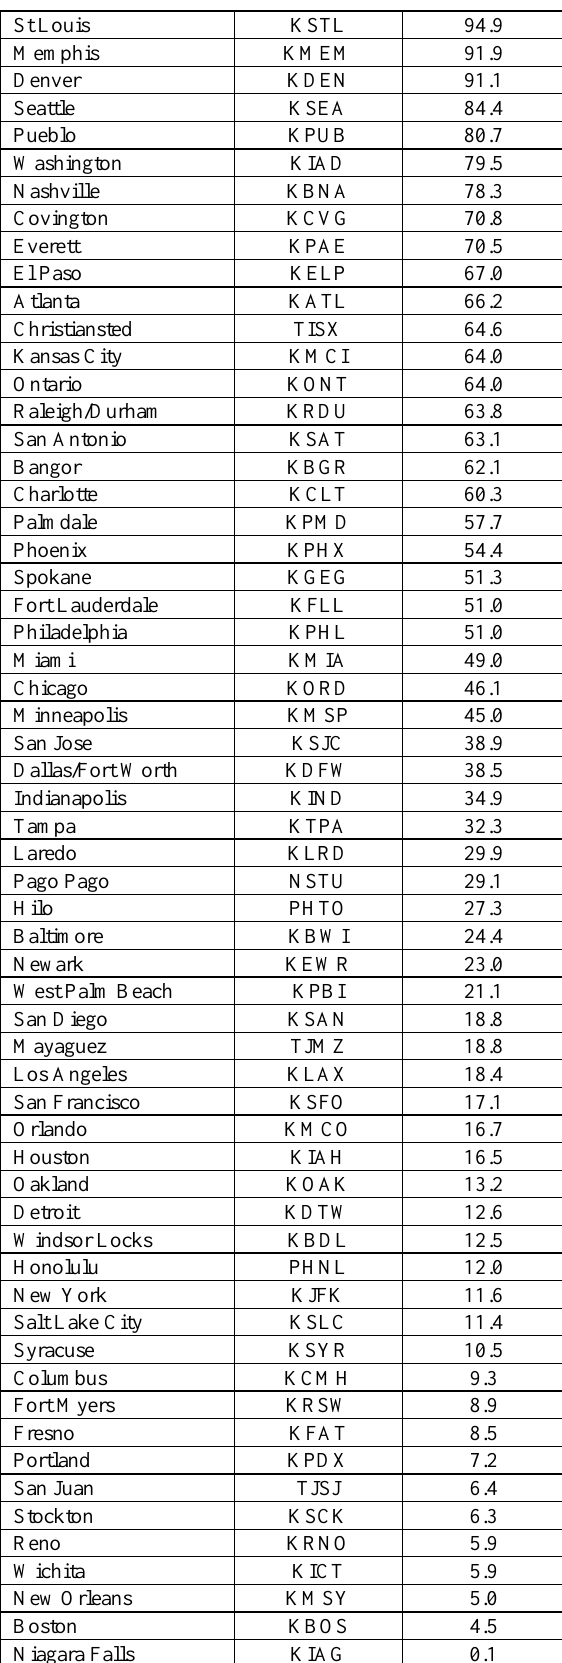
Figure 3. Histogram of the SRTM elevation for the Pittsburgh International Airport. The elevation anomalies are represented by lighter bars. A range of ‗correct‘ elevations is represented by darker bars. There were four data takes for this airport.